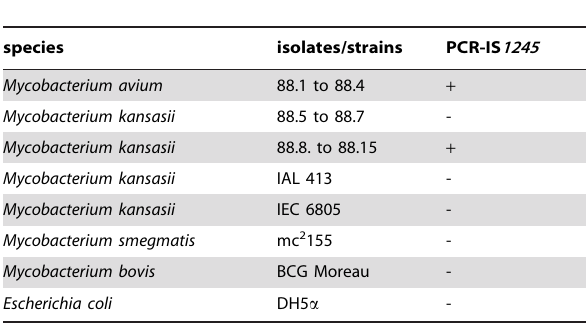
Table 2. Clinical isolates and strains used in this